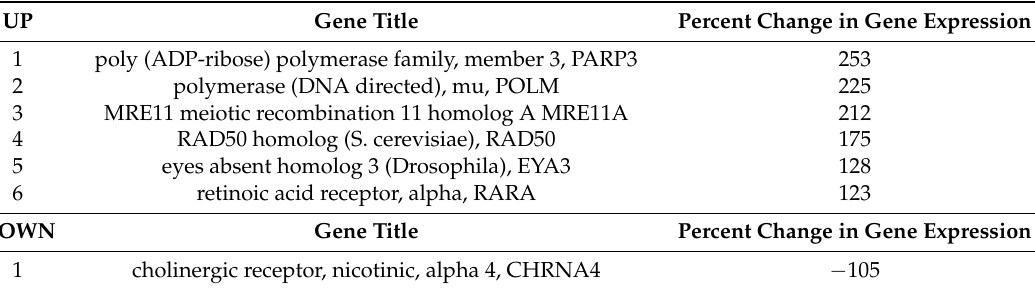
Table 8. GHK and Genes Associate with DNA